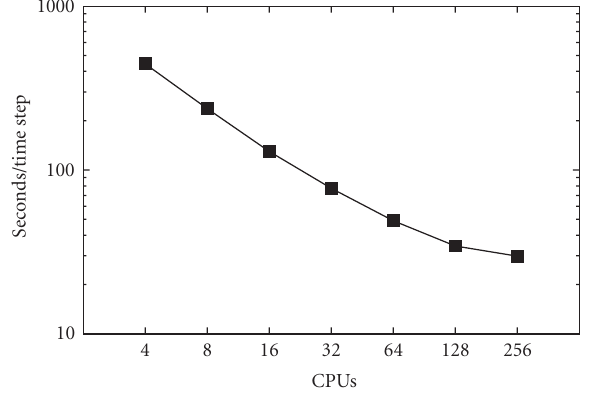
Figure 10: Representative AMROC scale-up test for fixed problem size. The abscissa shows the number of processors.